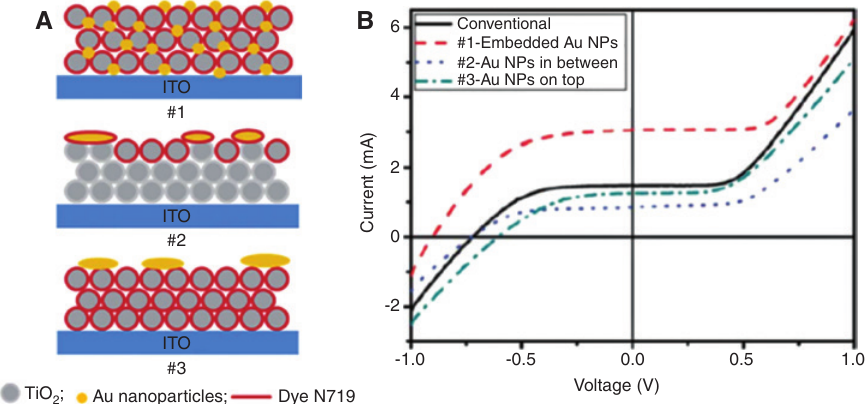
configurations, (B) I–V characteristics of DSCs with different 2